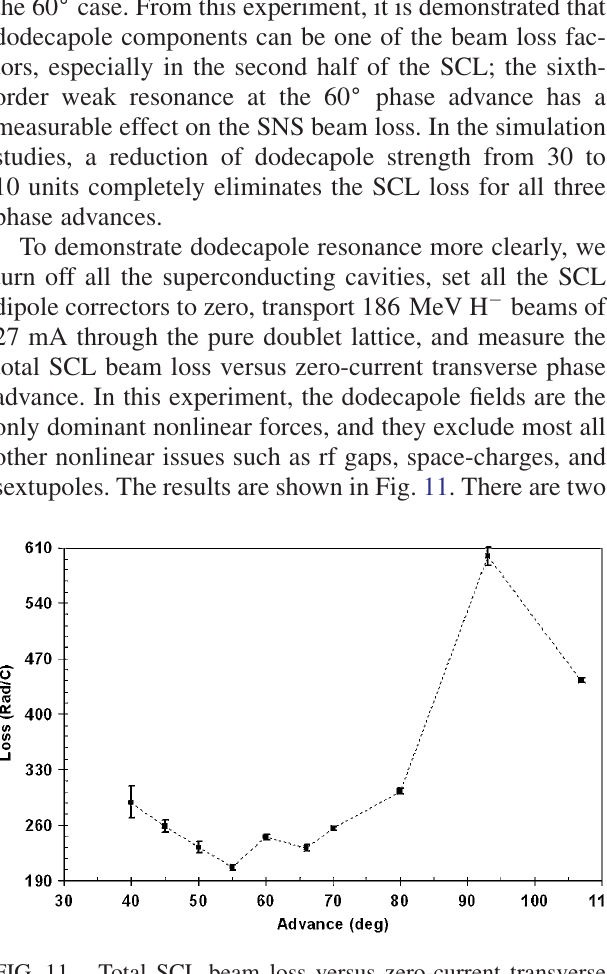
zero.FIG. 9. (Color) Model predicted SCL particle losses for the 50 (cid:1) , 60 (cid:1) , and 70 (cid:1) zero-current phase advance lattices.